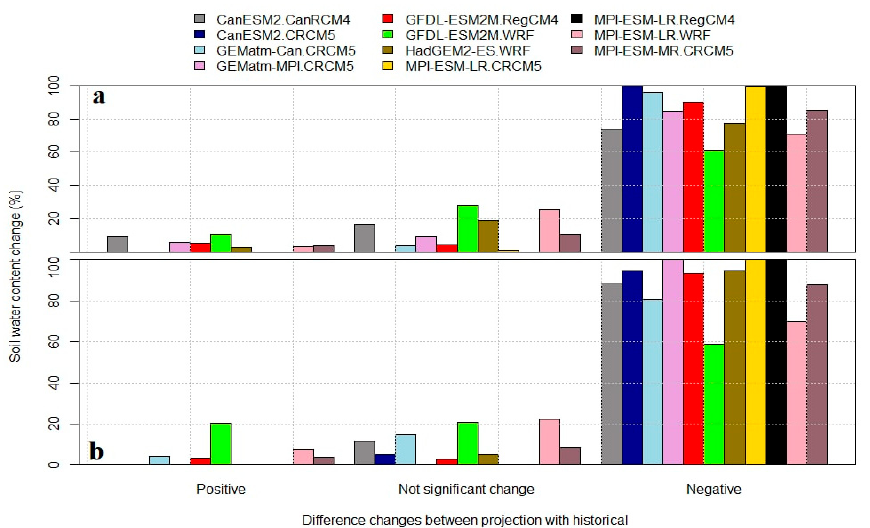
Figure 11. Spatial SWC change between RCM models in ( a ) near future and ( b ) distant future.